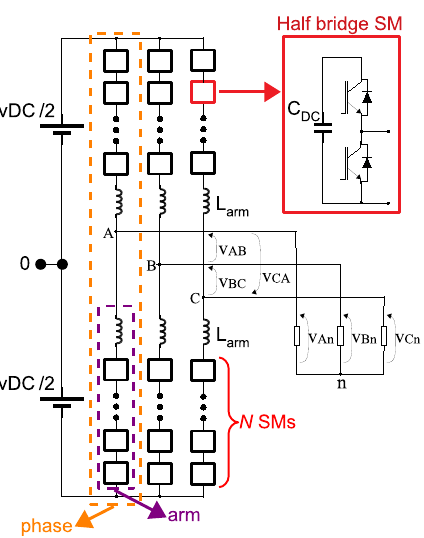
Figure 4. General schematics of a three-phase MMC (2 arms/phase and N